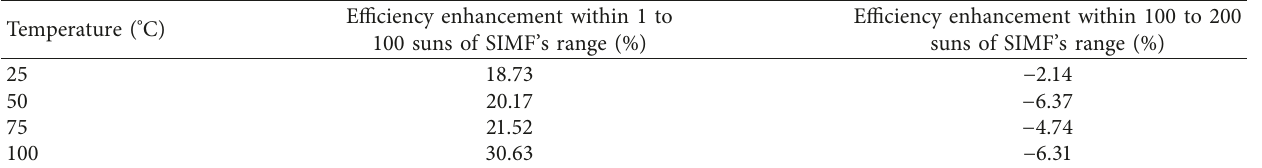
Table 2: The efficiency enhancement at various temperatures and SIMF’s